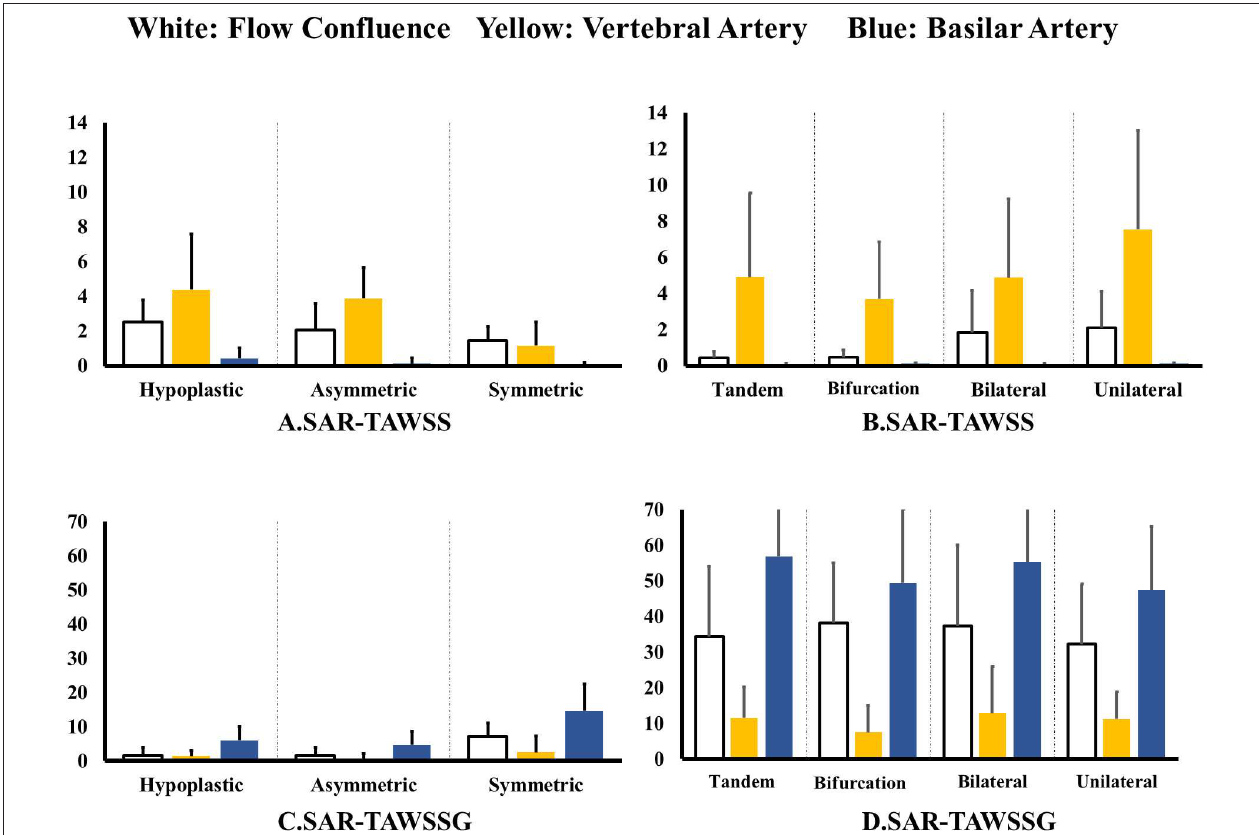
FIGURE 4 | (A,B) SAR-TAWSS within flow confluence, vertebral artery, and basilar artery in (A) symmetric, asymmetric, and hypoplastic groups and (B) unilateral, bilateral, bifurcation, and tandem stenotic sub-groups and (C,D) SAR-TAWSSG within flow confluence, vertebral artery, and basilar artery in (C) symmetric, asymmetric, and hypoplastic groups and (D) unilateral, bilateral, bifurcation, and tandem stenotic sub-groups.